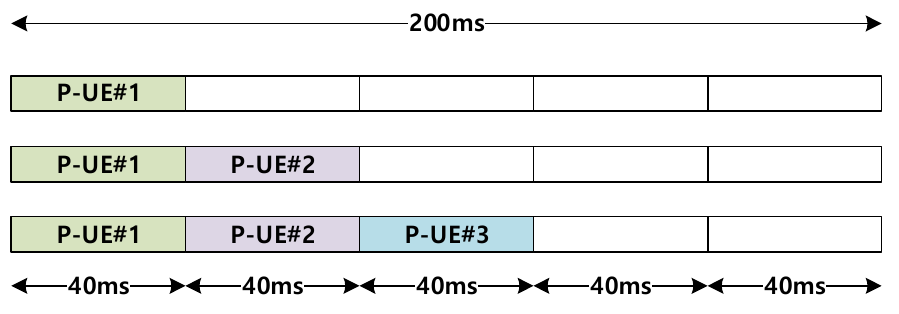
its own time slot.